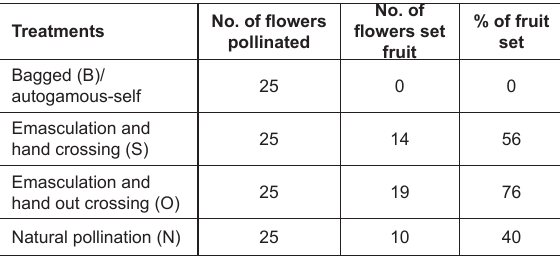
Table 4. Fruit set in different modes of pollination in Impatiens cuspidata Treatments